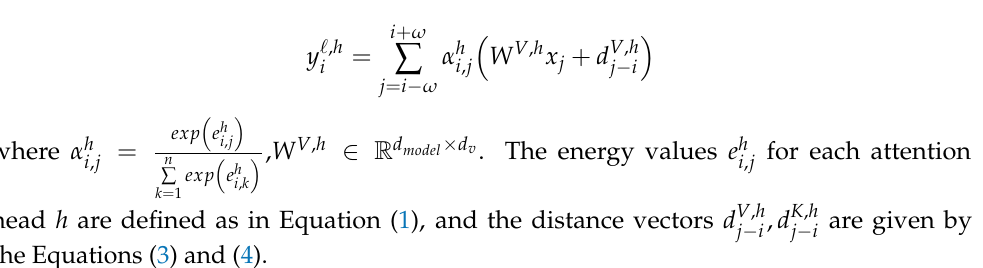
(cid:12) (cid:12)(cid:8) (cid:9)(cid:12) i : F T , T ( i ) = j (cid:12)